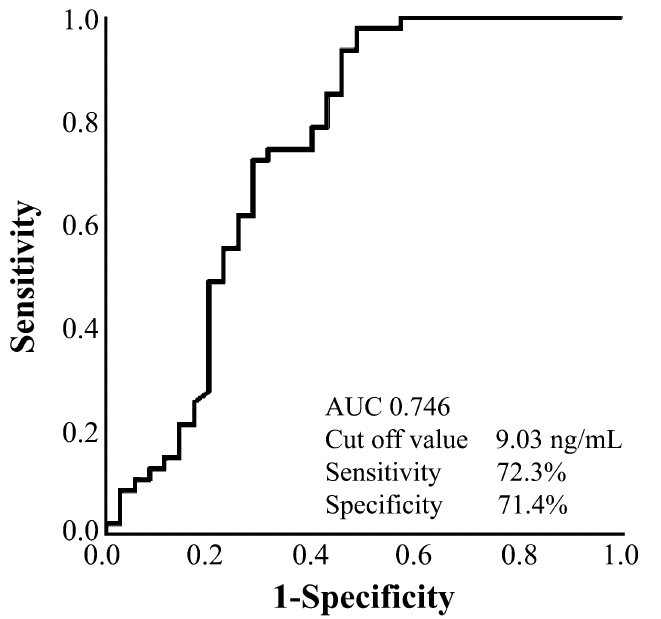
mesothelin-related peptides (SPSS Statistics V26 for IBM Japan (https:// www. ibm. com/ jp- ja/ produ cts/ spss- stati